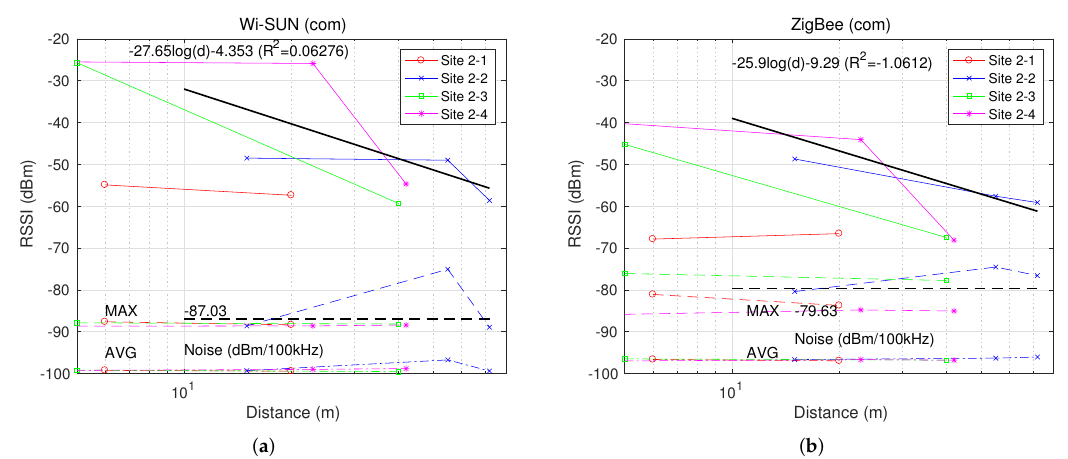
Figure 26. RSSI values for the Overhead Commercial Area. ( a ) Wi-SUN. ( b )